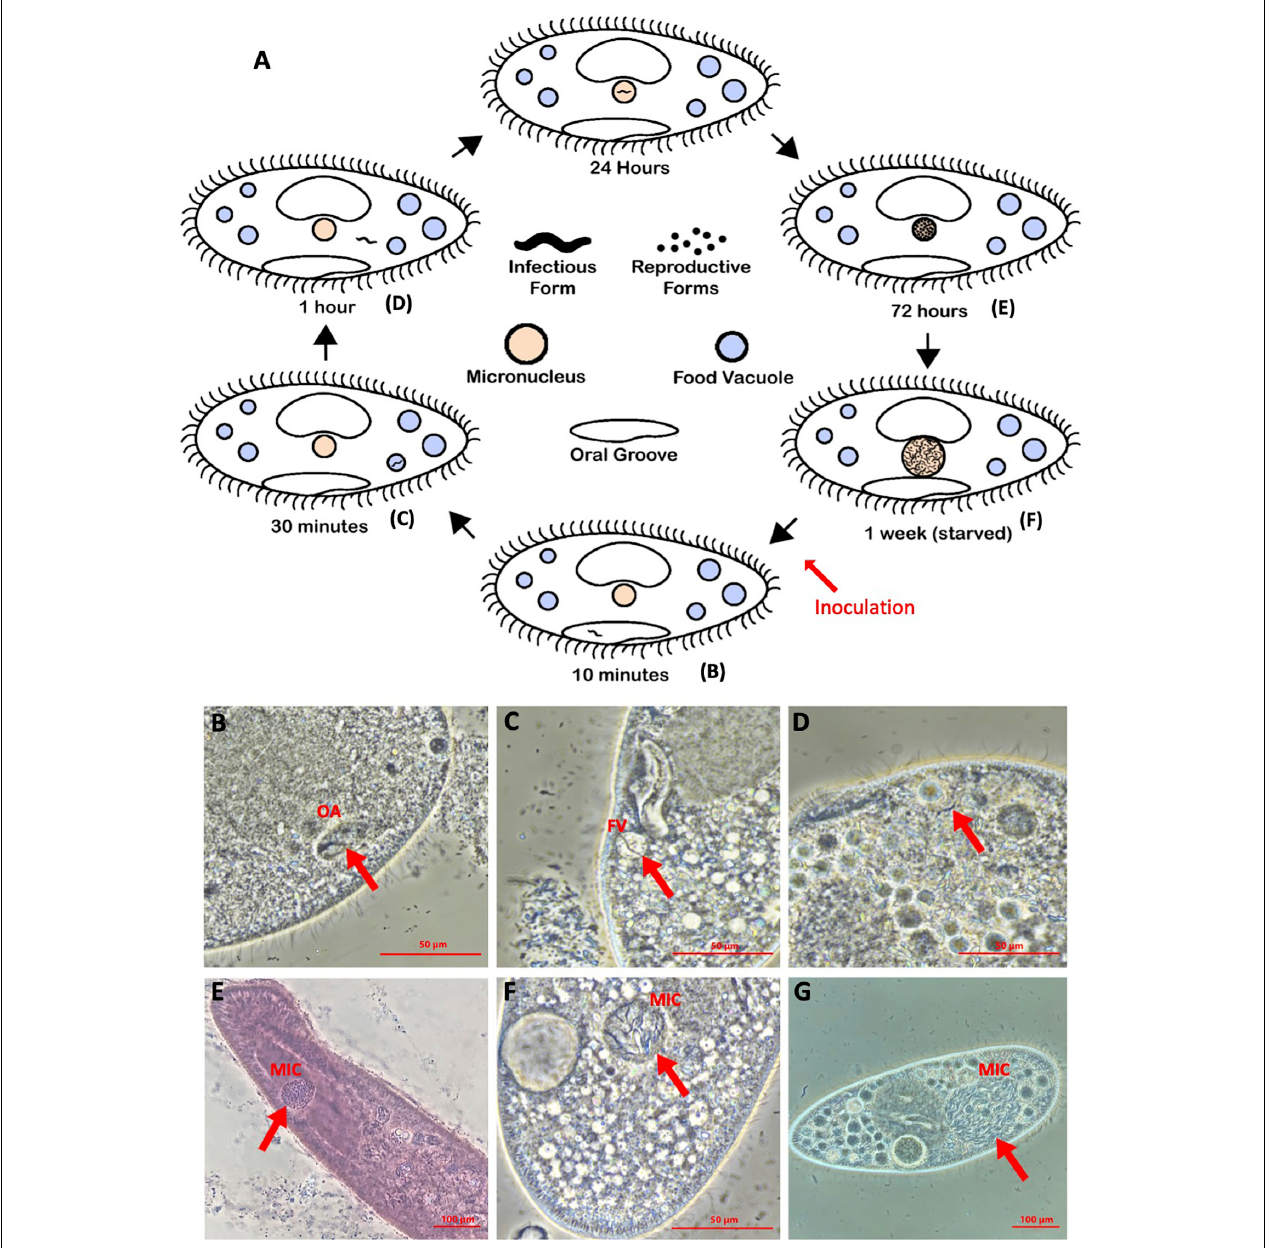
FIGURE 1 | (A) Holospora life cycle, diagrammed. (B–G) Representative images of timepoints in infection of Paramecium caudatum by Holospora undulata (on both the diagram and the microscope image panels): (B) IF within the oral groove (OA) at 10 min p.i. (C) IF in a food vacuole (FV) at 30 min p.i. (D) IF in the cytoplasm at 1 h p.i. (E) RFs in the micronucleus (MIC) at 3 days p.i. (d.p.i.) (F,G) IFs and RFs in the MIC at 7 d.p.i. (B–D,G) Live cell images, differential interference contrast. (E) Cell fixed with 5% glutaraldehyde and stained with lacto-aceto-orcein. (F) Cells fixed with 5% glutaraldehyde. All cells imaged on a Nikon Ti-S inverted microscope, using phase contrast, 40 ×